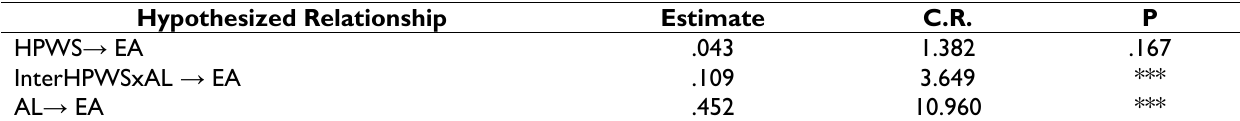
Table 7 . Moderation Analysis